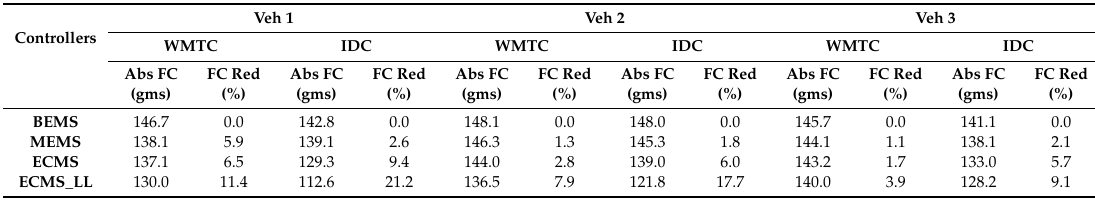
Table 3. Absolute fuel consumption and fuel consumption reduction percentage for di ff erent controllers tested with the WMTC and IDC test cycle for Veh 1, Veh 2 and Veh 3.